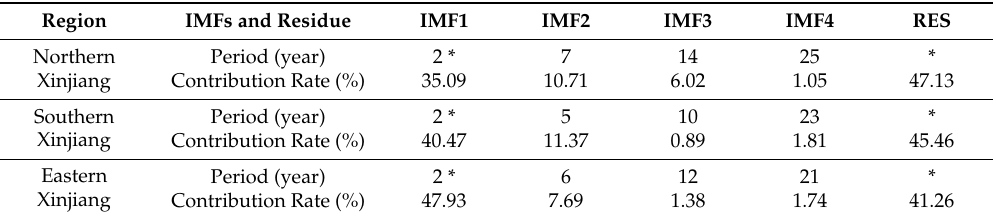
Table 3. The periods and variance contribution rate of each IMF for precipitation in different regions of Xinjiang.